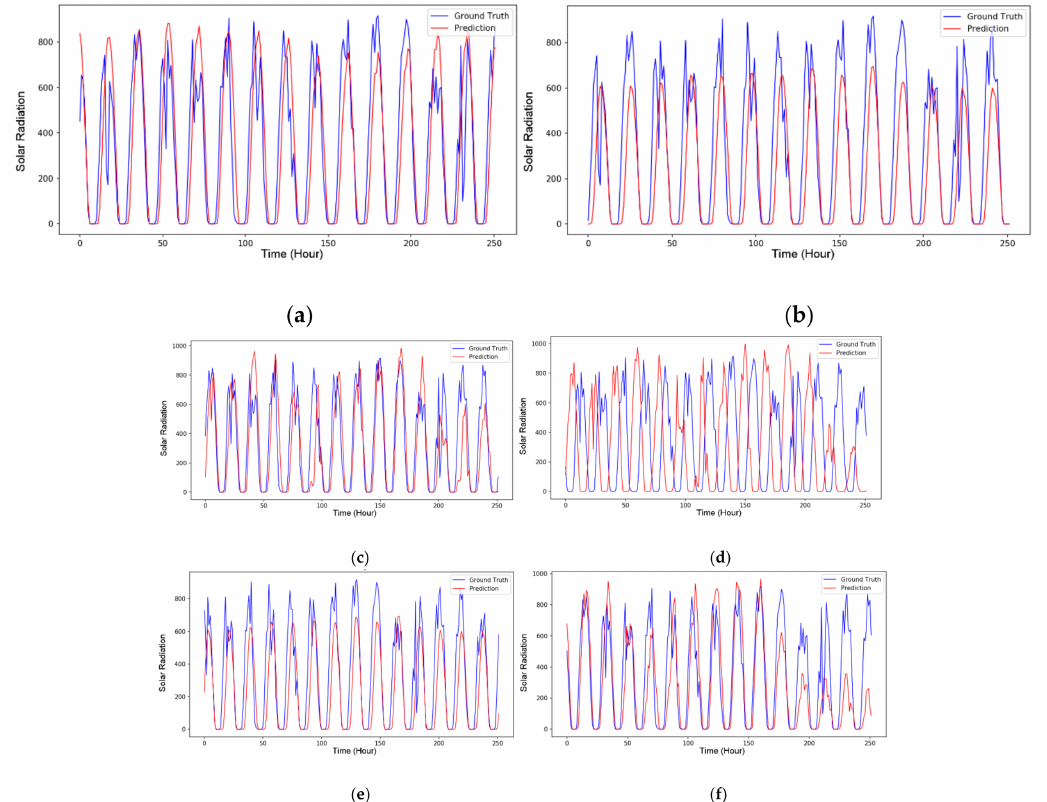
Figure 11. Forecasting results of decision tree: ( a ) Partial results A; ( b ) Partial results B; ( c ) Partial results C; ( d ) Partial results D; ( e ) Partial results E; ( f ) Partial results